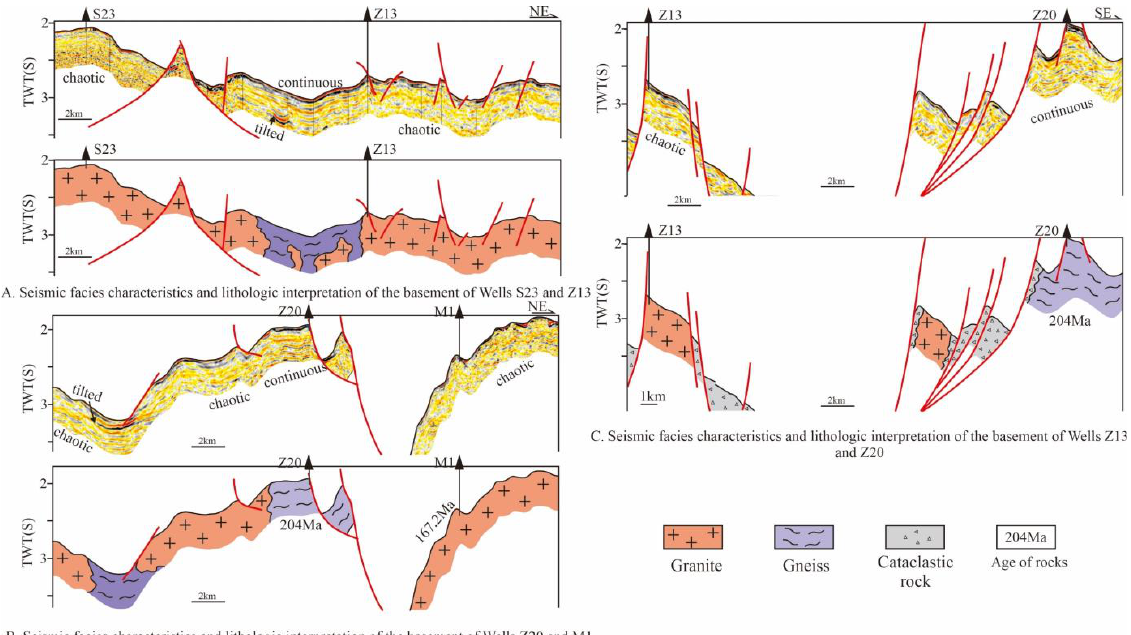
Figure 5. Seismic facies and lithological interpretation of the basement in the LS depression, ECSB. Note: Locations of the three seismic profiles are marked in Figure 1c. In ( A ), the upper figure is